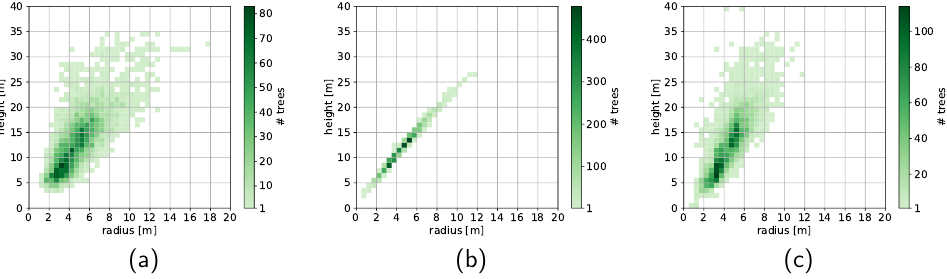
Figure 5. Three-dimensional tree size distribution in the test set. ( a ) Ground truth. ( b ) Height and z predicted by the network. ( c ) Verticality derived from the nDSM and